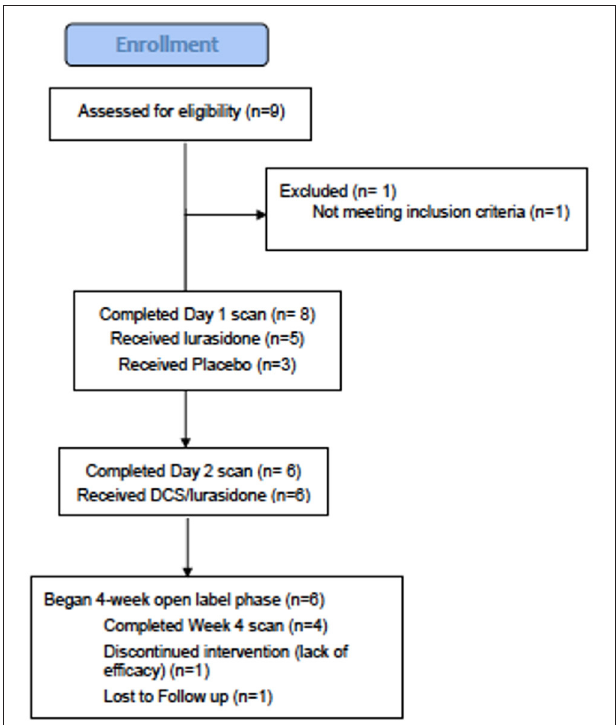
FIGURE 1 | CONSORT